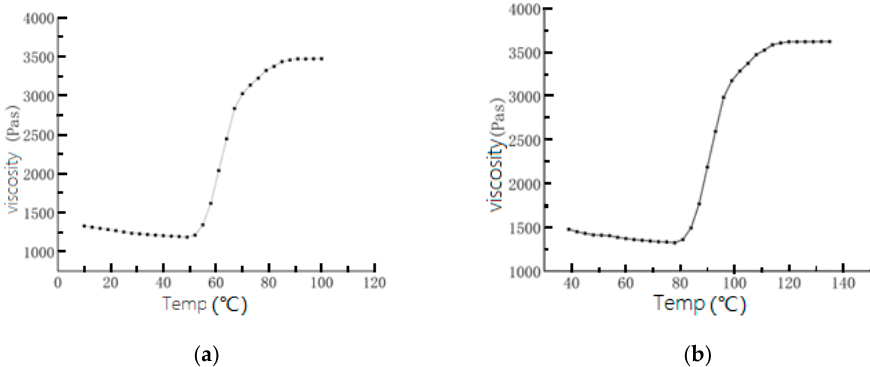
Figure 2. Properties of wood fiber gel material. ( a ) Cellulose gel; ( b ) Hemicellulose gel.